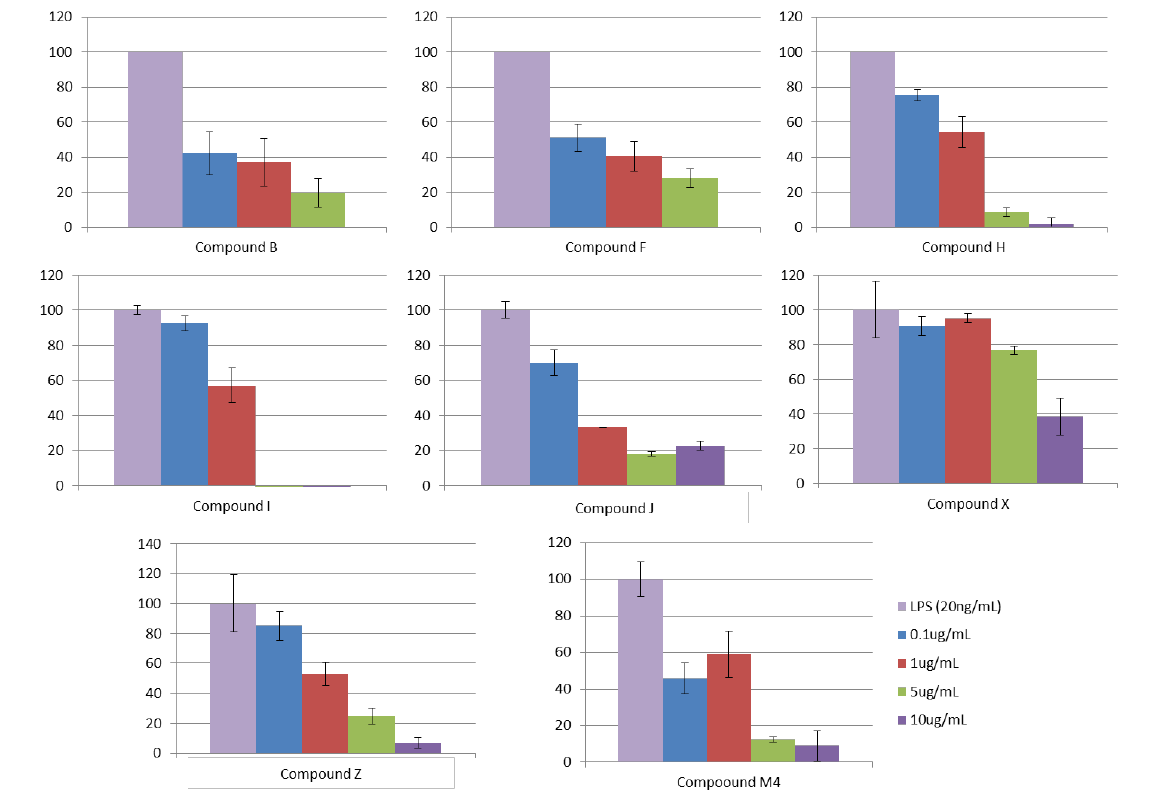
Figure 6. HEK-Blue TM treatment with increasing concentrations of compounds, stimulated with LPSs from E. coli . The results are expressed in the percentage of TLR4 activation (positive control: E. coli LPSs, 20 ng/mL). Table 3. Non LPS-like compounds identified with the TLR4/MD-2 antagonist activity. The calculated ADME parameters show the compounds have promising drug-like properties. The calculated logP is shown to illustrate the importance of a relatively high lipophilicity for the activity. a ChemScketch and b MolInspiration (www.molinspiration.com, accessed on 8 September 2022). Additional ADME parameters calculated with Swiss-ADME (http://www.swissadme.ch/, accessed on 8 September 2022) are c drug-likeness according to Lipinski’s rule and water solubility as d logS.